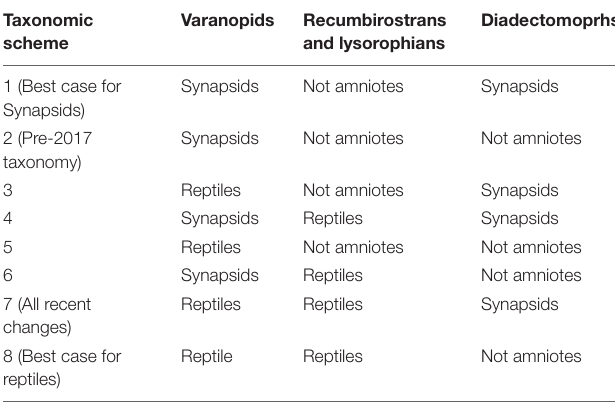
TABLE 1 | The eight taxonomic schemes used when calculating reptile and synapsed diversity, indicating to which clade the disputed lineages are assigned. Taxonomic